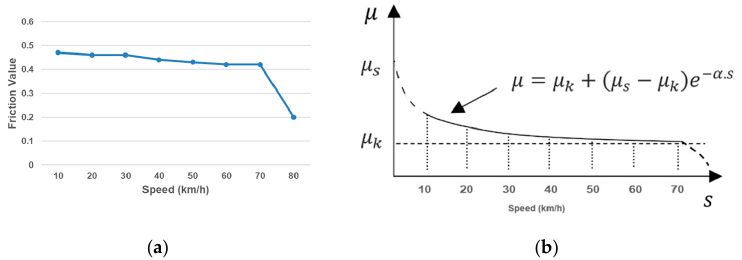
Figure 6. Comparison of DFT friction data with the exponential decay friction model: ( a ) DFT Friction Data; ( b ) Exponential Decay Friction Model (Oden and Martins, 1985).